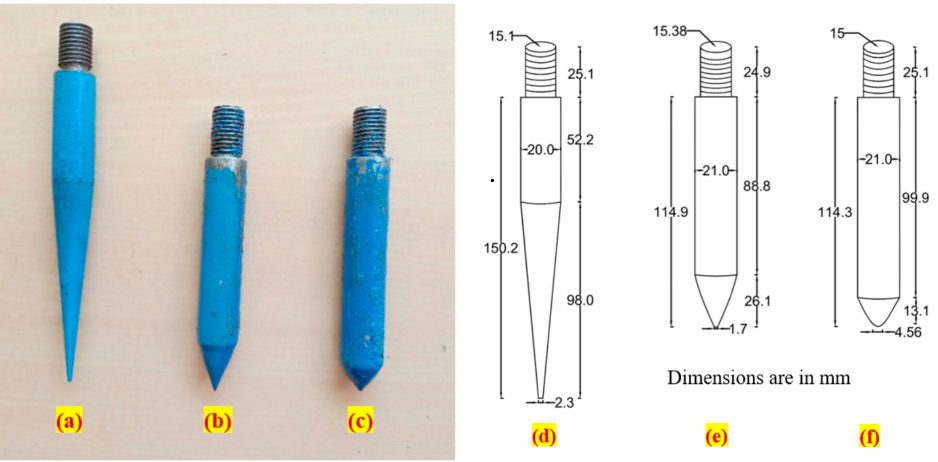
Figure 7. Details of the three types of projectile needle used in this research ( a , d ) compound bevel, ( b , e ) convex edge, ( c , f ) hollow